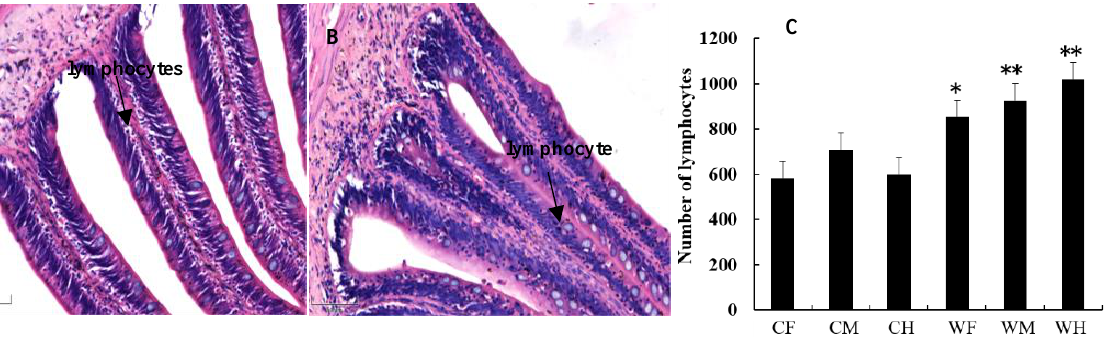
Figure 6. The distribution ( A , B ) and number ( C ) of lymphocytes in different gut segments between cultured ( A ) and wild ( B ) Hemibarbus maculatus . The number of lymphocytes in the gut tract of the wild group was larger, while the difference between foregut and hindgut was significant, and that in the midgut was very significant. Note: n = 30, the data were misrepresented by average ± standard, * indicates significantly different from those of the cultured (wild) group ( p < 0.05), ** indicates significantly different from those of cultured (wild) group ( p < 0.01). (H.E., bar = 50 μm ).